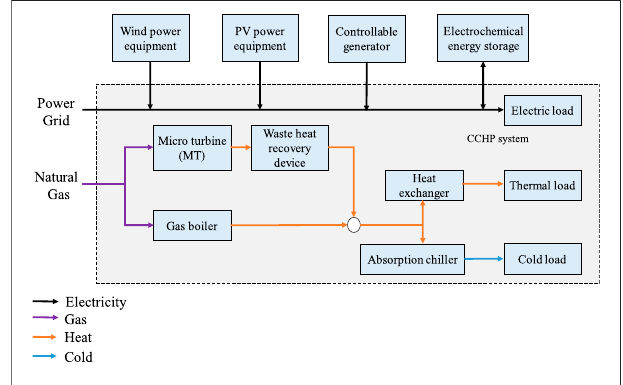
FIGURE 2 | Combined cooling, heating, and power